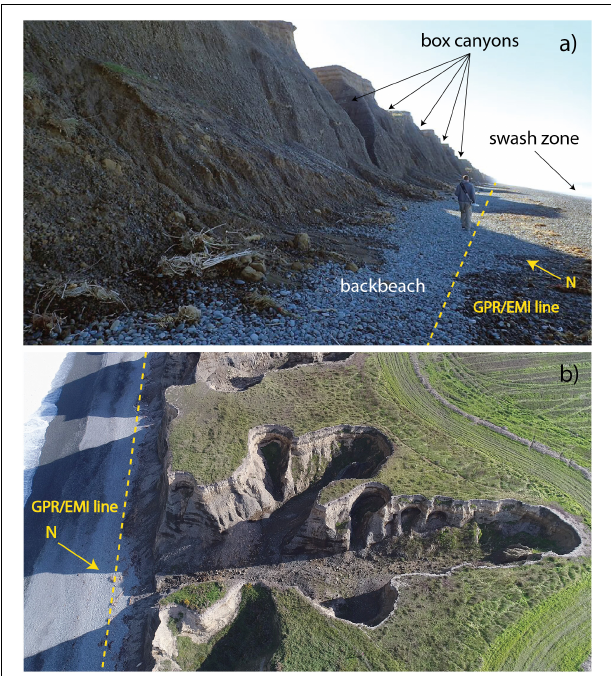
FIGURE 3 | Image showing the location of the coincident alongshore GPR/EMI surveys and adjacent cliff and box canyon morphology (a) . Aerial view (b) of a representative box canyon (view to the SE). Images taken between May 5–8,